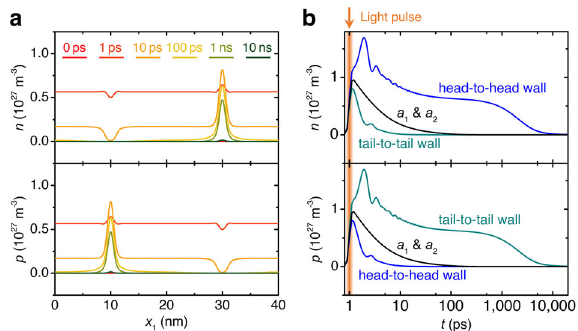
Fig. 4 Charge carrier dynamics in 90° domains with head-to-head and tail-to-tail domain walls. a Spatial distribution at selected times. b Their temporal evolution inside a 1 and a 2 domains and at the center of domain walls. Fig. 5 Structural dynamics in 90° domains with head-to-head and